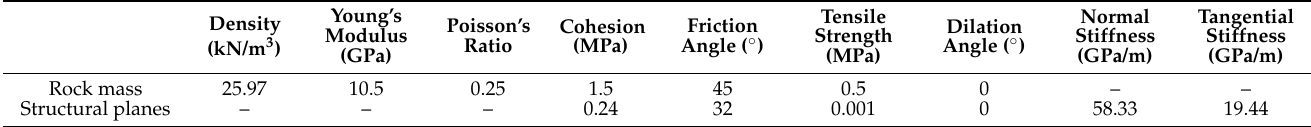
Table 1. Physical and mechanical parameters used for the rock mass and structural planes.